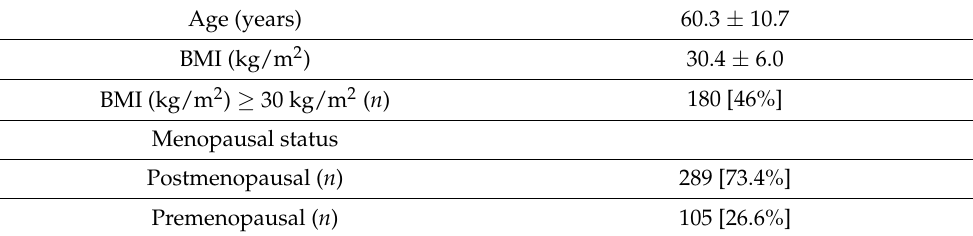
Table 1. Selected demographic features of the studied group of women (body mass index—BMI).